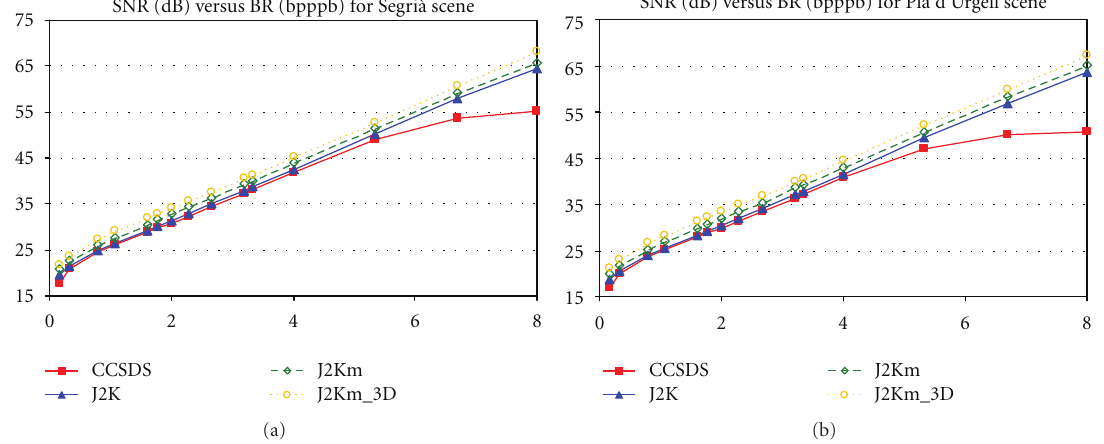
Figure 6: SNR (in dB) in relation to the bit rate (in bpppb) obtained for the images recovered of the studied crop areas and for the four compression strategies. (Please note that the y -axis is not the same as in Figures 4 and